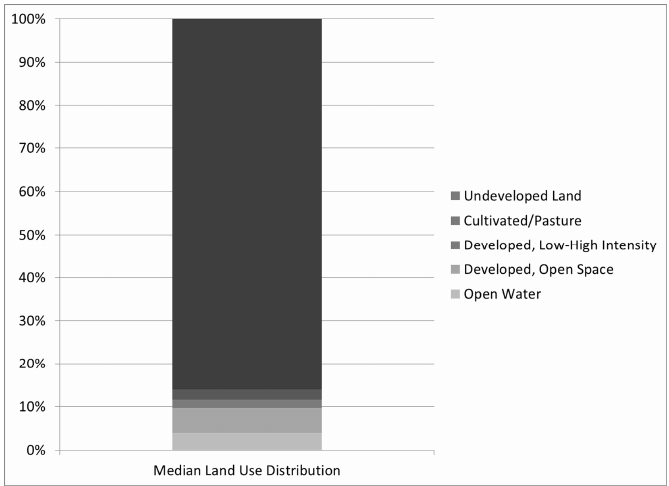
Figure 4. Median land use distribution across 2206 N removal dams draining to the Atlantic from New England. Water 2016 , 8 , 522